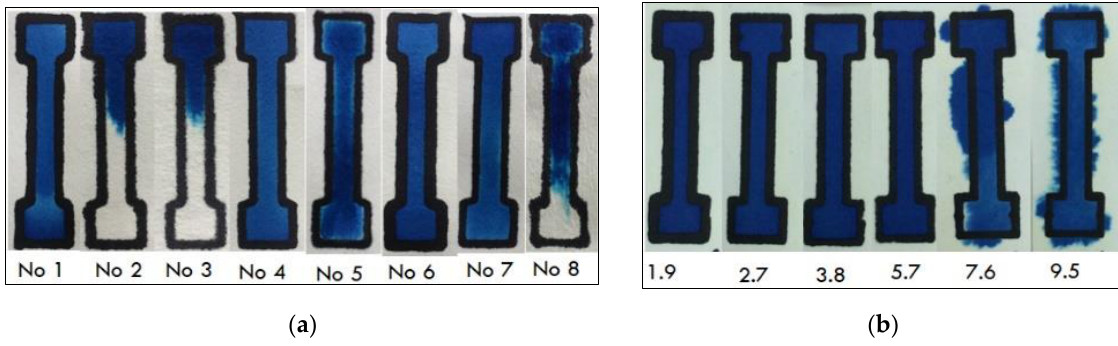
Figure 2. Photos illustrating ( a ) longitudinal solution transport in the 8 different types of papers (100 μL of methylene blue; pen No 17; two passes; single-sided; pen plotting speed 2.7 cm s −1 ), ( b ) the effect of the plotting speed (in cm s −1 ) on the isolation ability and the barrier line width (100 μL of methylene blue; pen No 17; paper No 5; single-sided plotting; 2 passes).